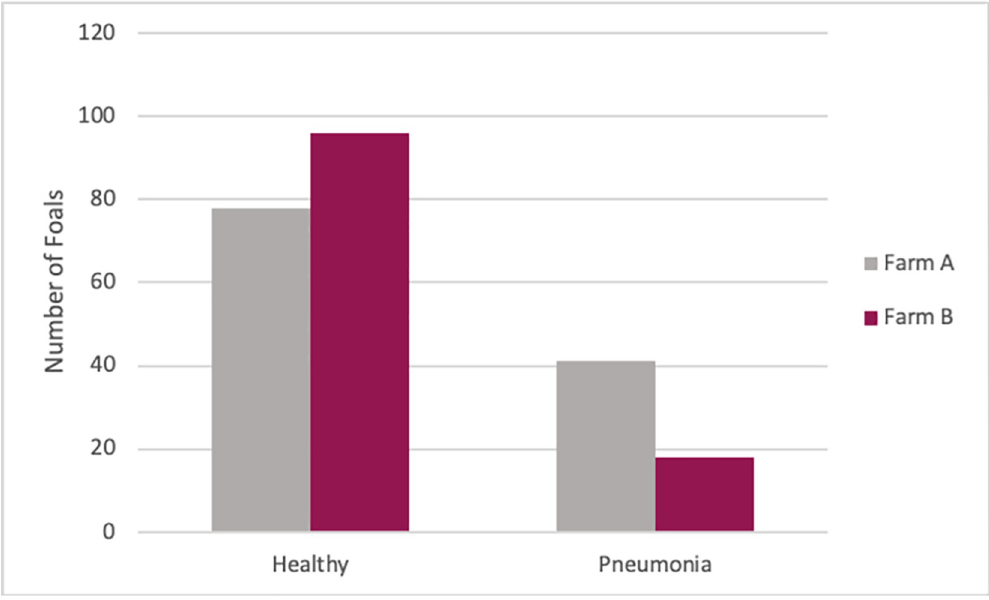
Fig 8. The distribution of foals that developed pneumonia by Farm. The distribution of 233 foals that remained healthy or developed pneumonia stratified by Farm on the X axis. At Farm A in grey, 34% (41/119) of foals developed pneumonia and Farm B in maroon, 16% (18/114) of foals developed